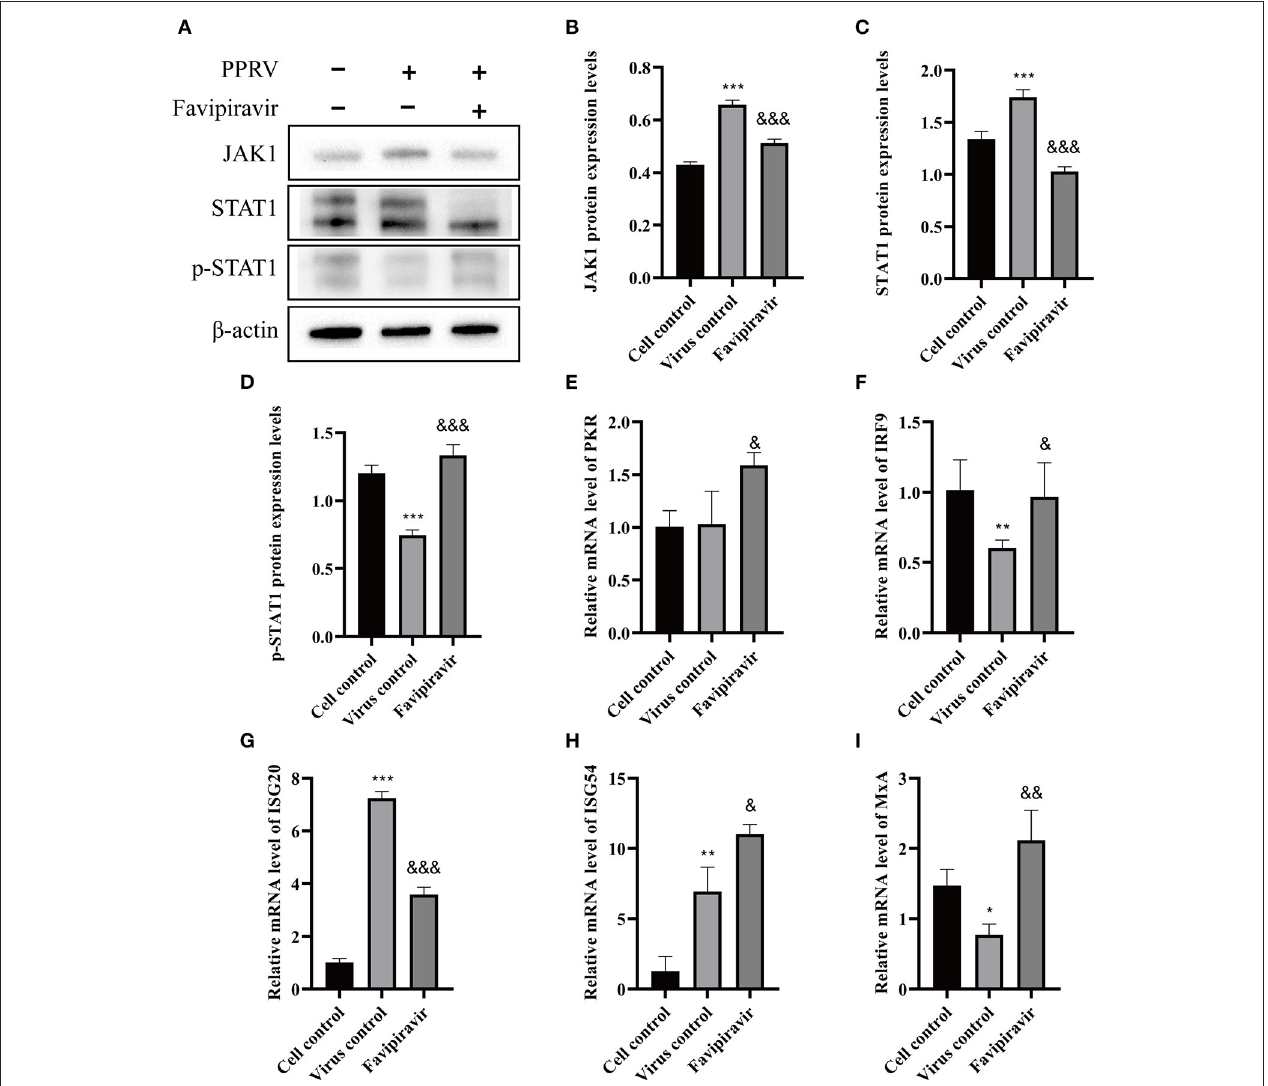
FIGURE 6 | The effect of favipiravir on the expression levels of proteins and mRNAs related to the JAK/STAT signaling pathway (A–I) . Vero cells were simultaneously treated with favipiravir and infected with peste des petits ruminants virus (PPRV), and protein expression levels were measured 48h after infection. The detection of JAK1 (B) , STAT1 (C) , and p-STAT1 (D) expression levels by Western blotting. The relative mRNA levels of PKR (E) , IRF9 (F) , ISG20 (G) , ISG54 (H) , and MxA (I) were detected by qRT-PCR ( & p < 0.05, && p < 0.01, &&& p < 0.001 vs. the virus-only control; * p < 0.05, ** p < 0.01, *** p < 0.001 vs. the cell